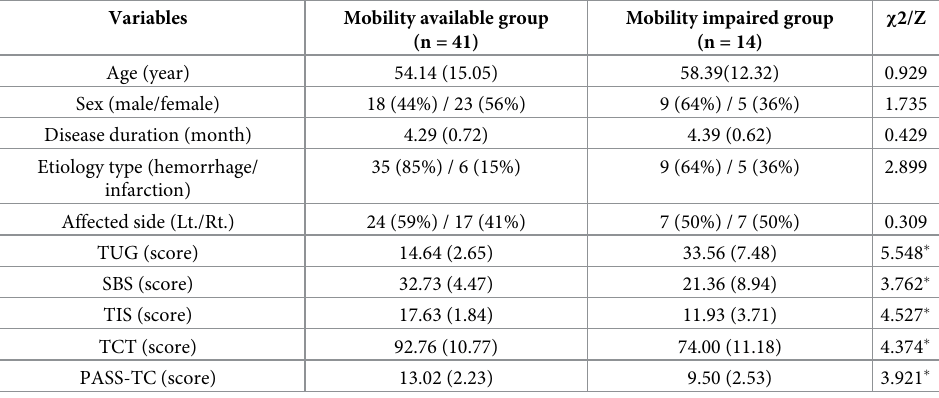
Table 1. Participants’